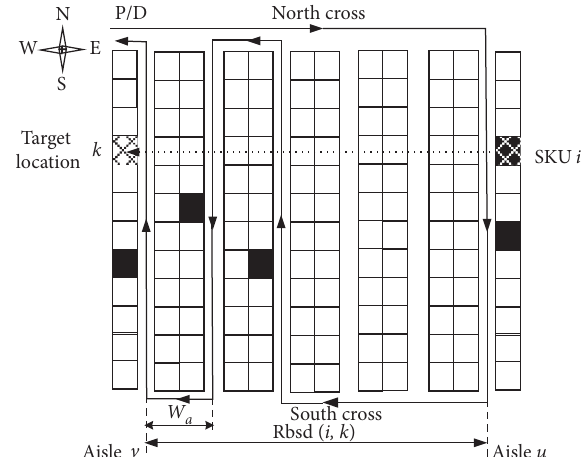
Figure 3: Calculation of route-based saving